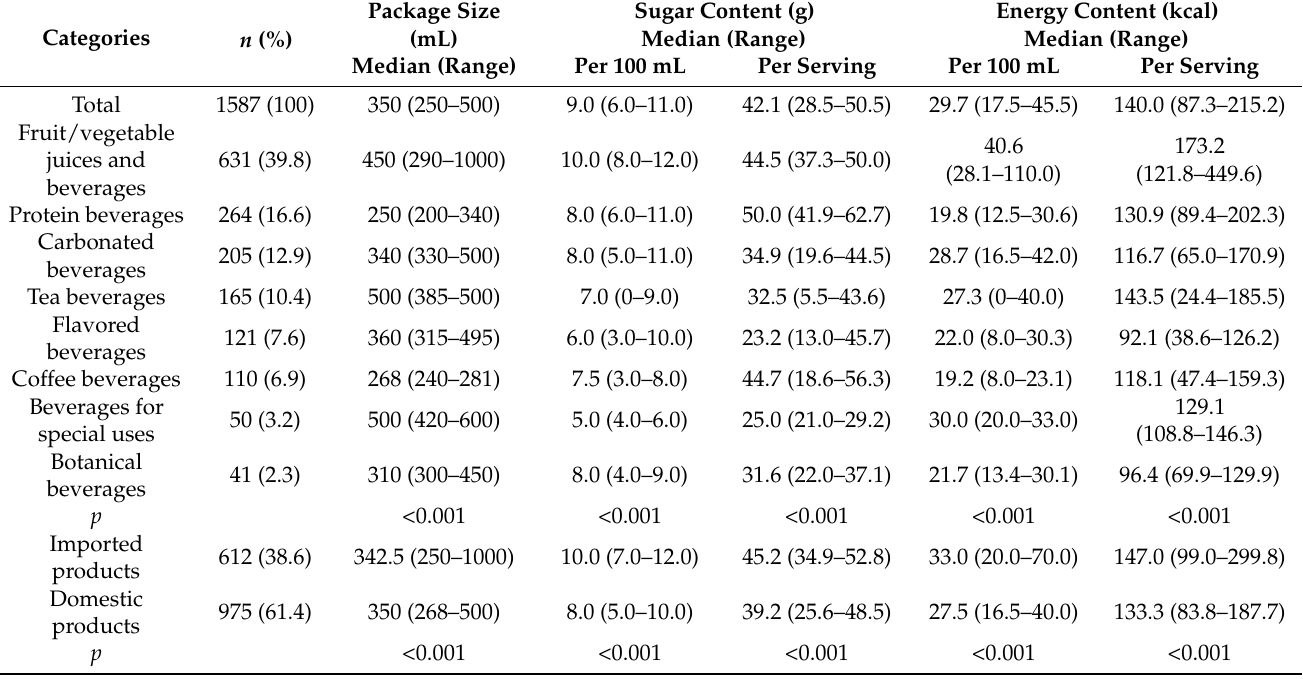
Table 1. Description of median (IQR) sugar and energy content in different